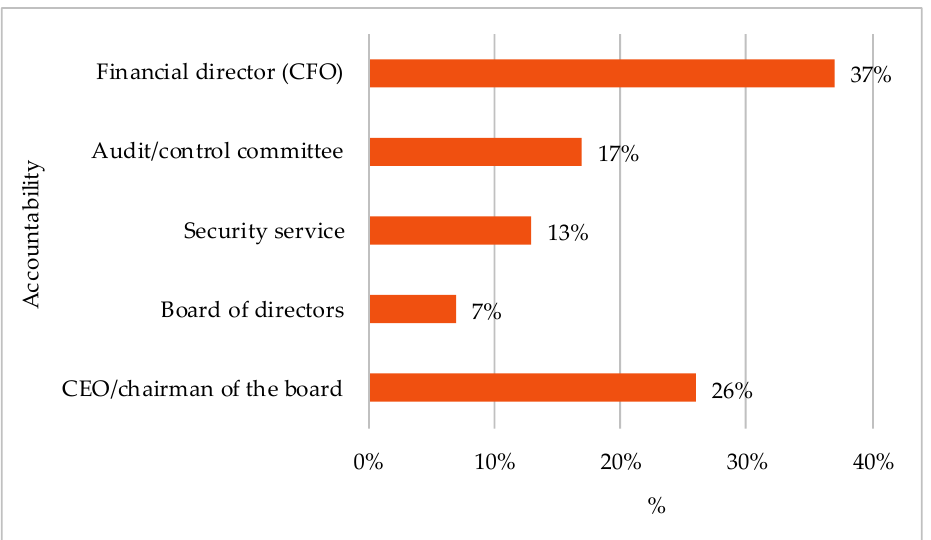
Figure 3. Accountability of the structural division responsible for the coordination of risk management in 50 Polish companies. Source: authors’ study.